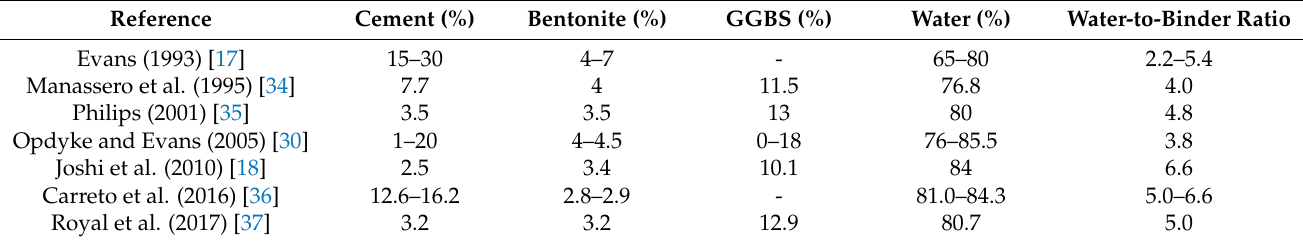
Table 1. Summary of reported values of the cement, bentonite, water, and GGBS proportions in cement–bentonite barriers. Reference Cement